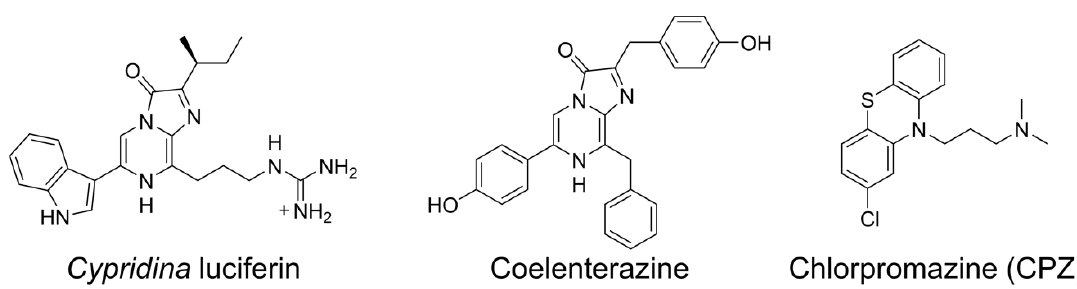
Figure 1. Chemical structures of compounds used in this study.